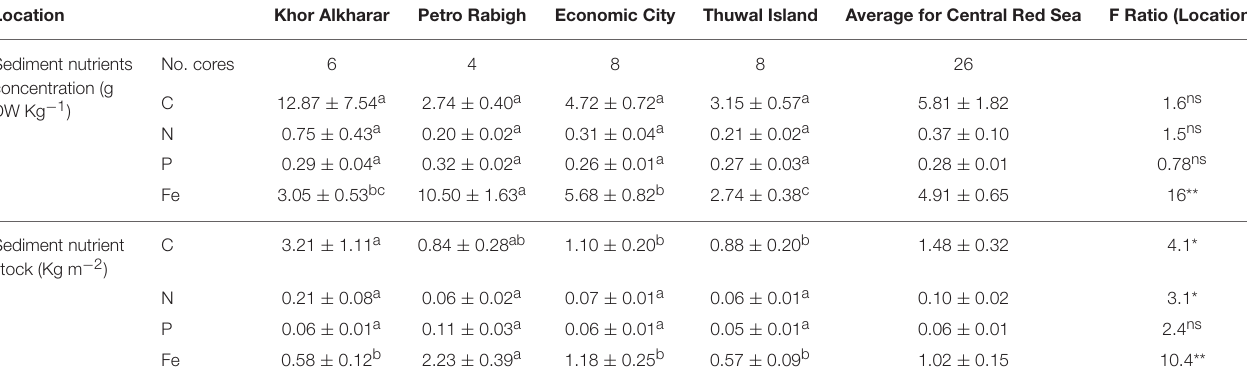
TABLE 3 | Mean ( ± SE) of nutrient concentration (g DW Kg − 1 ) and accumulated stock (Kg m − 2 ) in the top 30cm of the sediment from four different mangrove locations in the Central Red Sea and the results (F-ratio and results from post-hoc Tukey HSD analysis) from ANOVA to tests for differences between locations. Location Khor Alkharar Petro Rabigh Economic City Thuwal Island Average for Central Red Sea F Ratio (Location) Sediment nutrients concentration